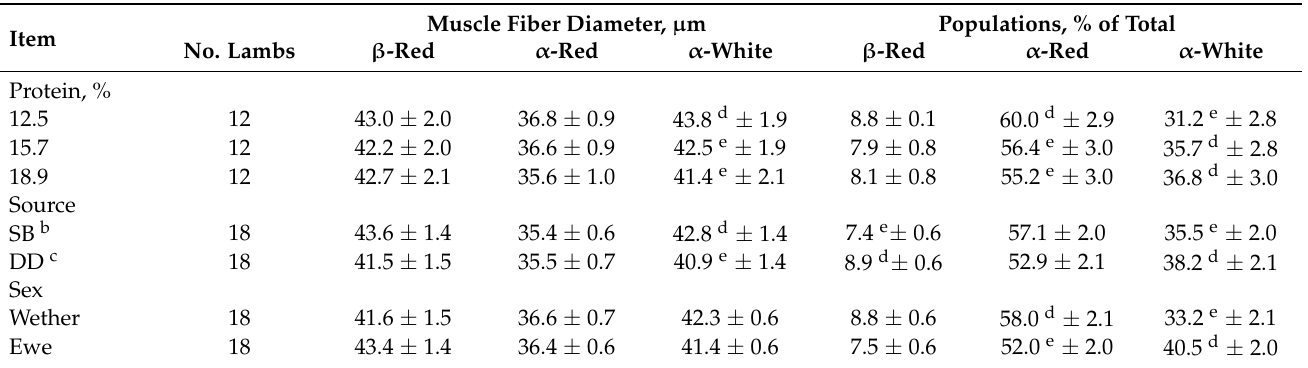
Table 2. Least squares means and standard errors for size and population of muscle fibers and size of fat cells in longissimus muscle a